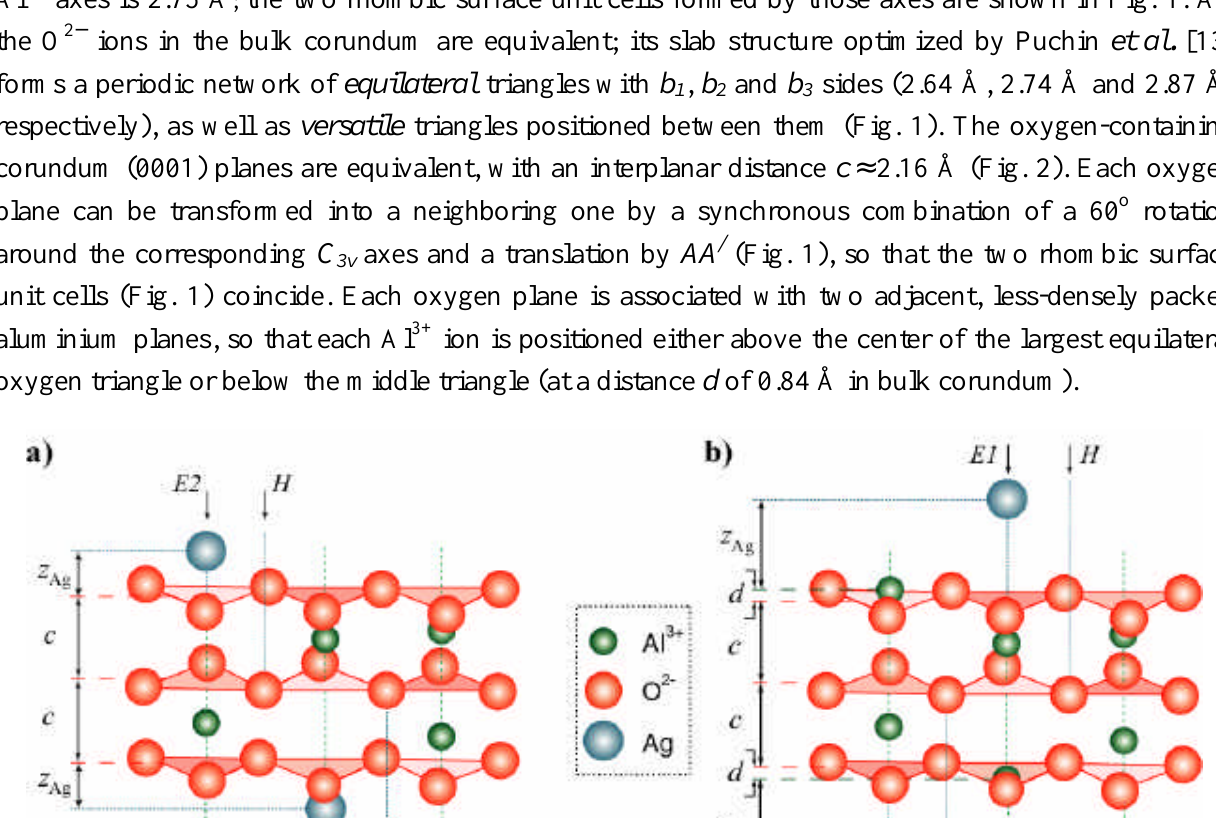
parameters. The most Ag